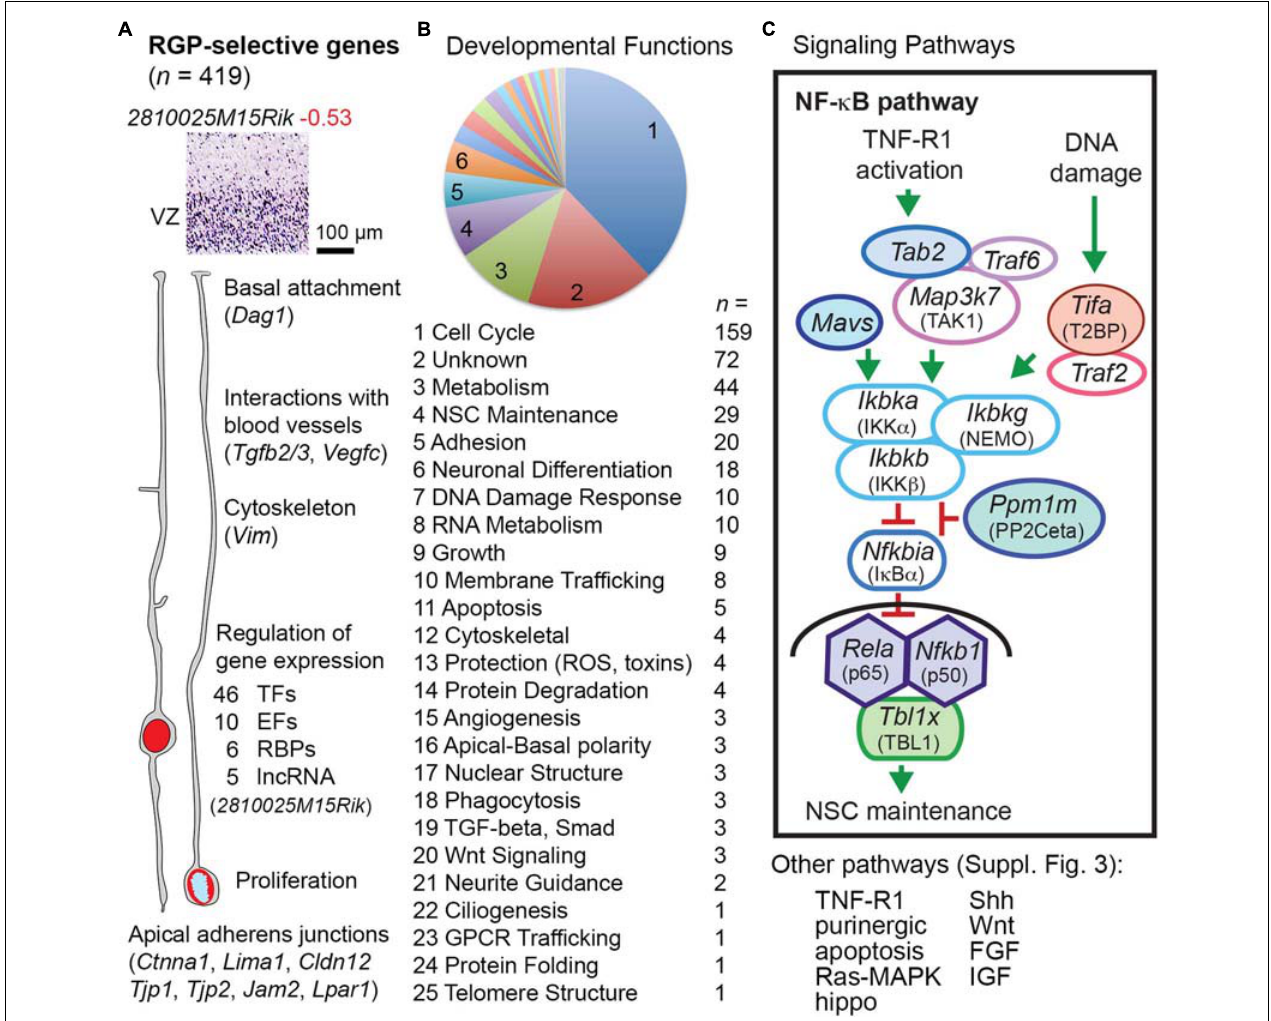
FIGURE 3 | RGP-selective genes. (A) The example transcript ( 2810025M15Rik ) is a ncRNA of unknown function. Some key functions of RGP-selective genes and examples are indicated. (B) Developmental function categories of RGP-selective genes. (C) RGP-selective genes (indicated by colored shading) were highly linked to certain signaling pathways such as NF- κ B. Components of the transcription complex (p65, p50, and TBL1) were all RGP-selective, as were upstream activators and repressors of the pathway. Shapes with white fill represent genes expressed in multiple cell